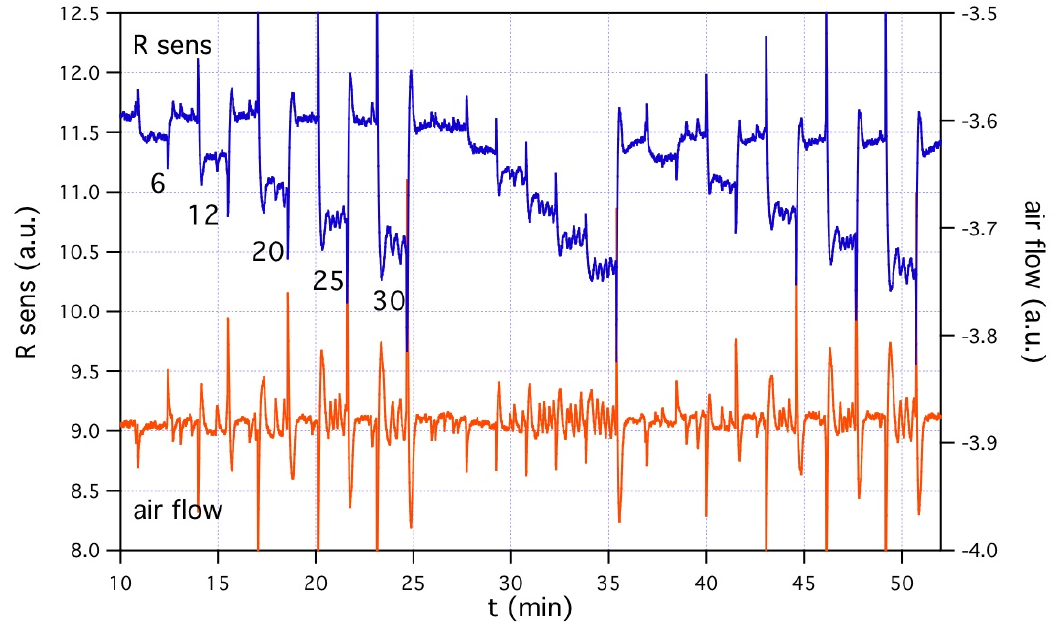
Figure 5. Top graph: example of device characterization, where gas sensing is performed contemporarily to anemometric air-flow measurements. Gas sensing graph is the blue one, referring to left axis; air-flow graph is the orange one, referring to right axis. The testing gas was hydrogen, at the labeled concentrations; both the chemical sensor and the anemometer were operated at 200 °C. Air-flow measurements require in-line insertion of device along gas pipeline. This condition gives the device the possibility to see, on both the gas sensor and the anemometer, real fluctuations -of chemical composition as well as of flow- due to the action of mass flow controllers of testing facility, as clearly appear in both graphs. Bottom graph: sensor response based on data of top graph (see